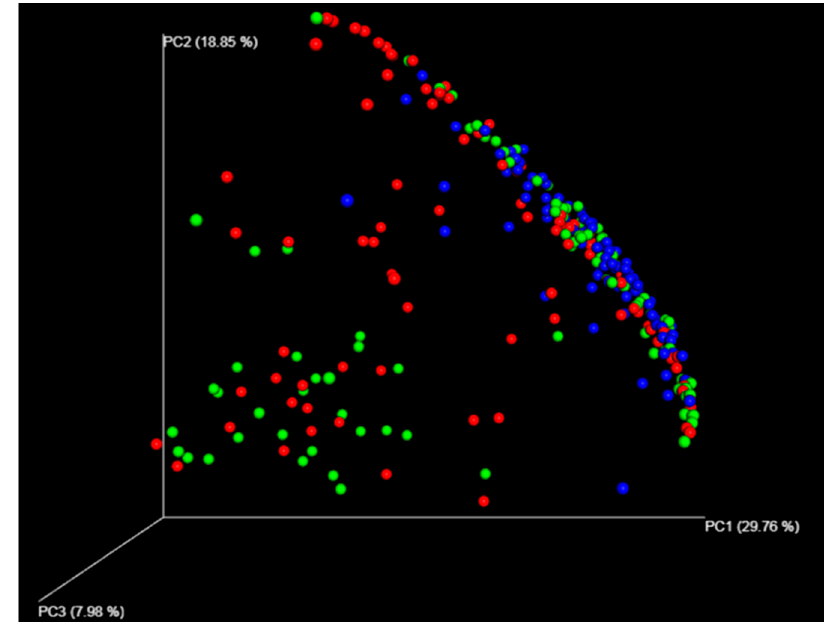
Figure 1. Beta diversity comparisons of microbial communities in the antrum, body, and duodenum. Principal coordinate analysis (PCoA) plots for the antrum (red), body (green), and duodenum (blue) are shown to determine Bray–Curtis distances. In the permutational multivariate analysis of variance, microbial communities in the antrum and the body showed similarity with a pseudo F-value of 4.52 ( p = 0.003, q = 0.0030), whereas those in the antrum and duodenum showed dissimilarity with a pseudo F-value of 16.15 ( p = 0.001, q = 0.0015). Furthermore, microbial communities in the body and duodenum showed Bray–Curtis dissimilarity with a pseudo F-value of 11.86 ( p = 0.001, q = 0.0015). Table 1. Differences between subjects according to the status of Helicobacter pylori infection. With no Helicobacter pylori Findings